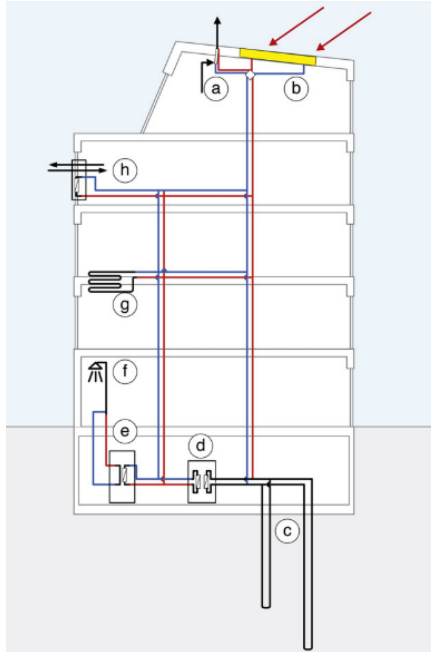
Figure 11. Integration of low-exergy systems in a prototype building in Zurich [39]. (a) Exhaust heat recovery; (b) PV panels with heat recovery; (c) dual zone boreholes; (d) heat pump; (e) low temperature hot water storage; (f) warm wastewater recovery; (g) ceiling panels; and (h) decentralized heat